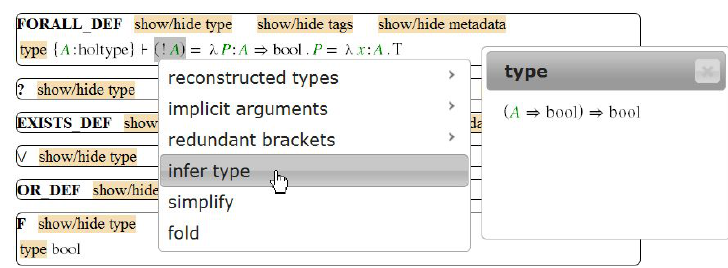
Fig. 4. Type Inference in the Mmt Web